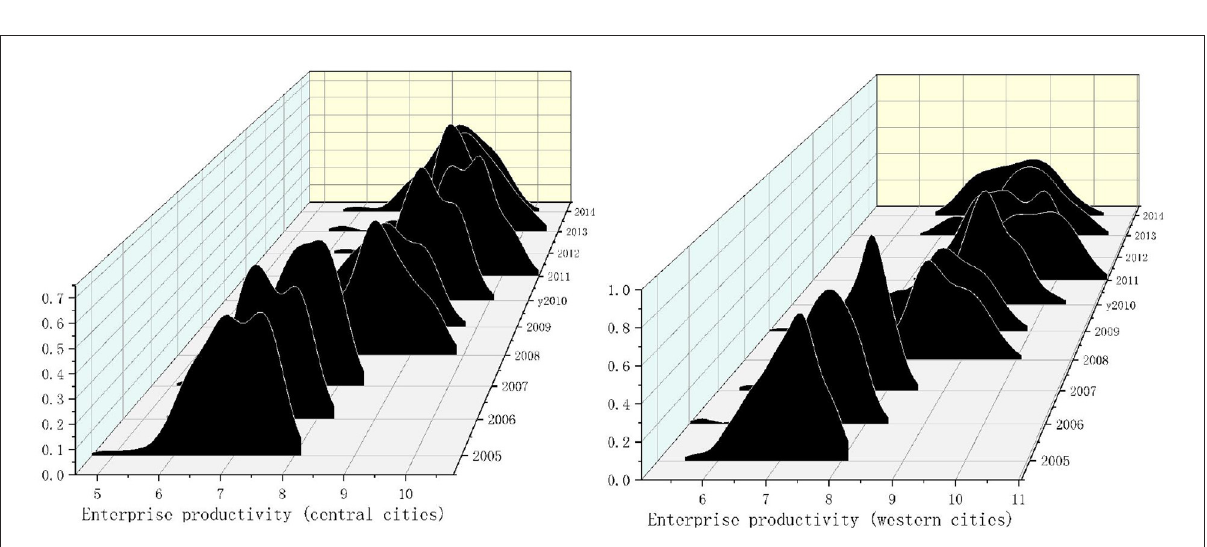
FIGURE2 Kernel density of enterprise productivity in central and western cities from 2005 to 2014. Note: the closer the kernel density graph to the right, the higher the productivity. The higher the kernel density graph, the more concentrated the